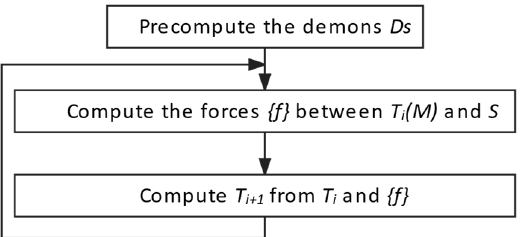
Figure 6. Block diagram of the multimodal registration algorithm for matching X-ray and CT images.